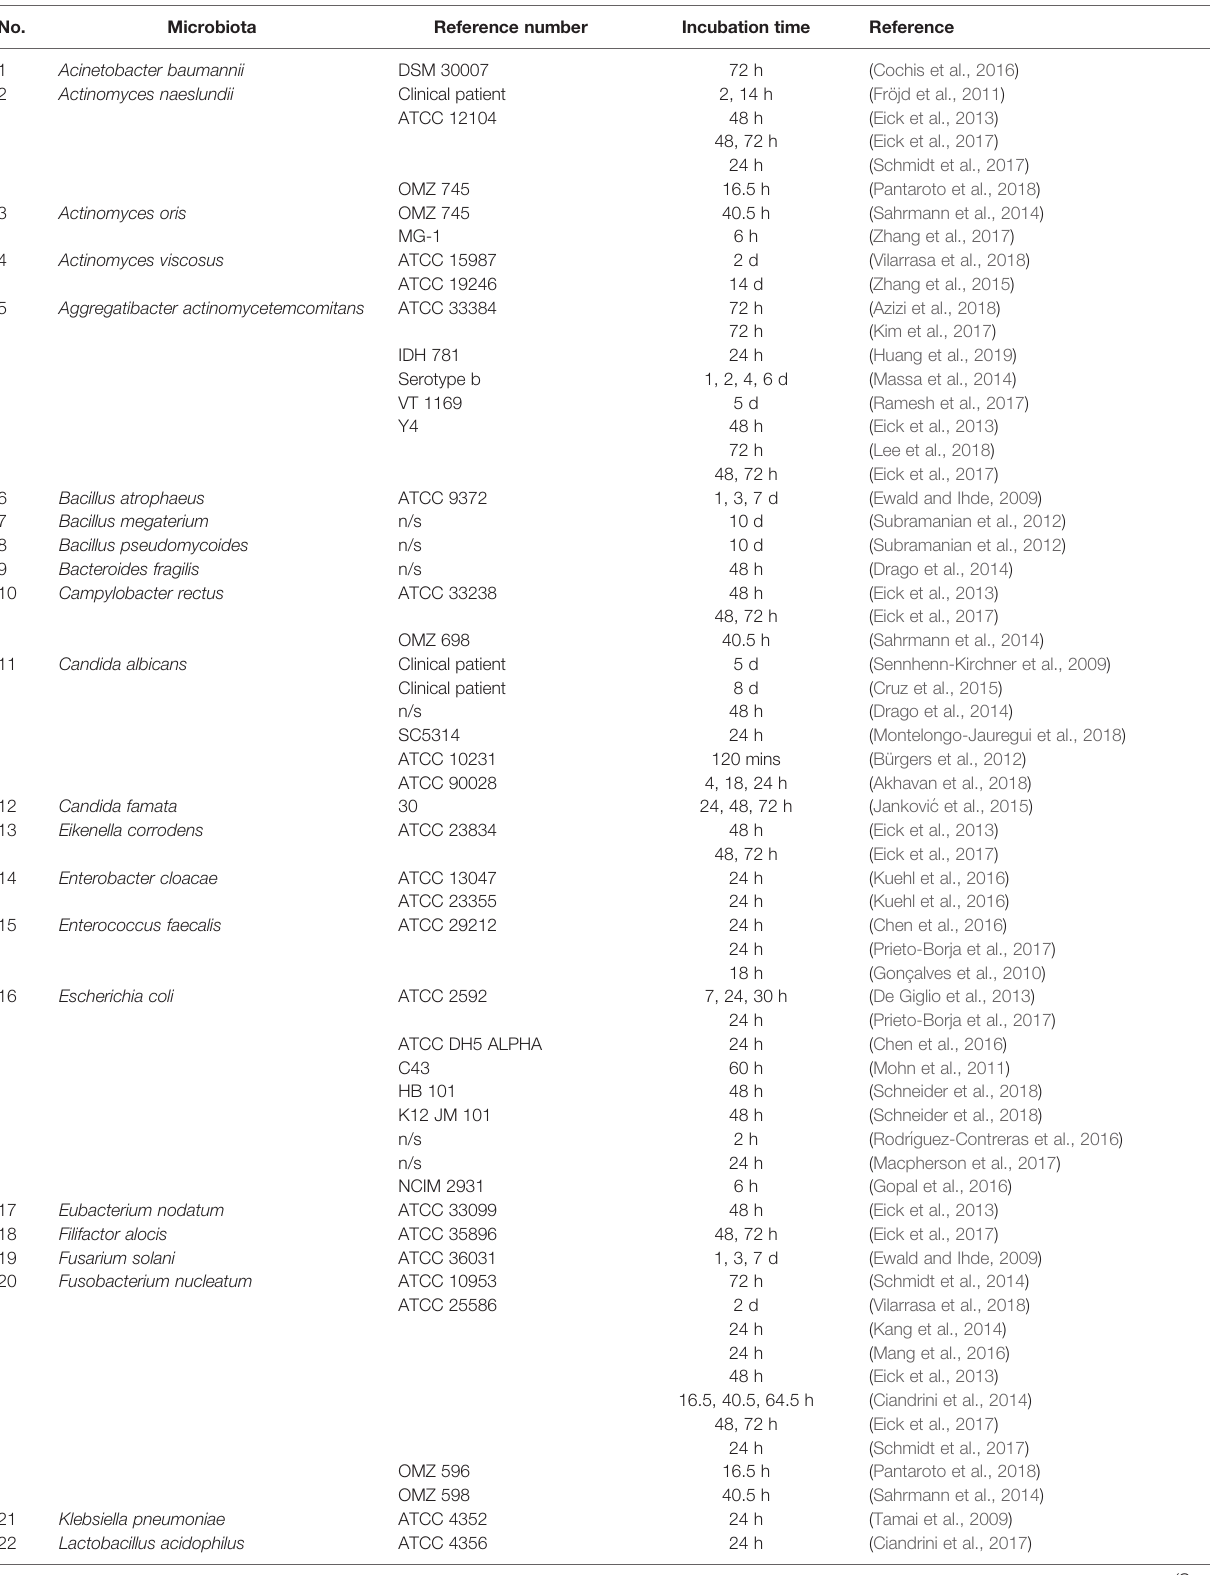
TABLE 2 | List of microbiota used for the development of bio fi lm on the titanium